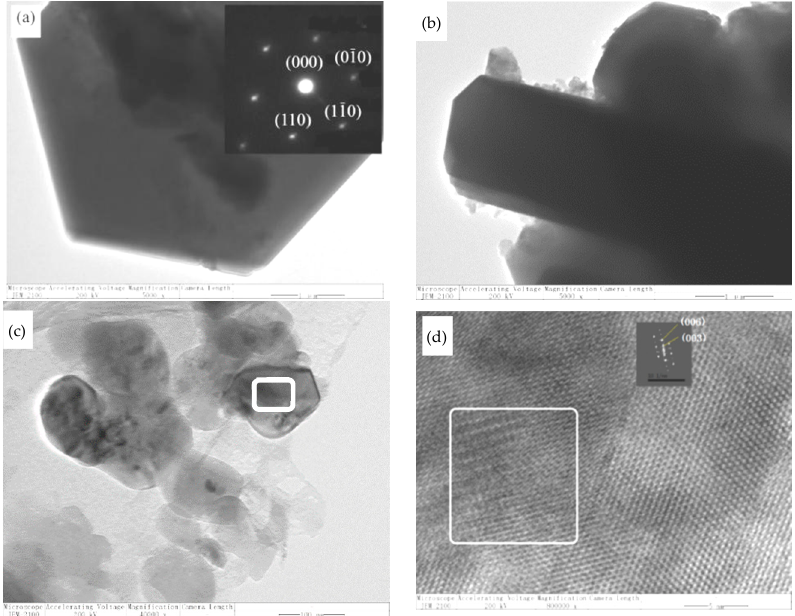
Figure 5. HRTEM micrographs of ( a ) hexagon or ( b ) bar-type and ( c ) nano-Al 4 C 3 , and ( d ) selected area electron diffraction of ( c ).